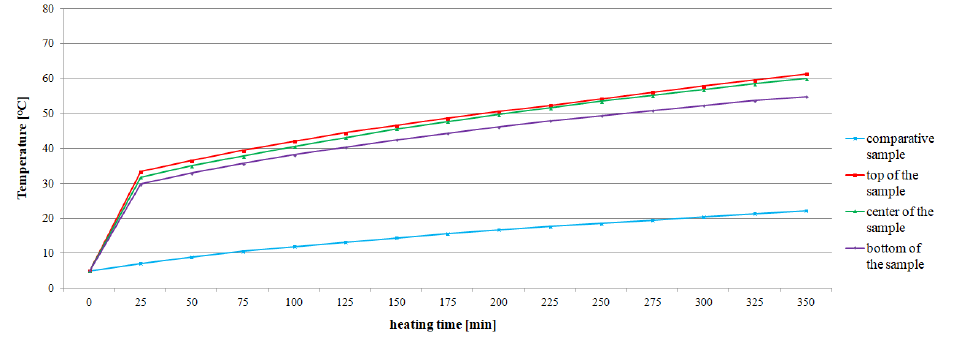
Figure 9. Change of the average temperature of CC-2 concrete as a function of heating time and test site on the sample.